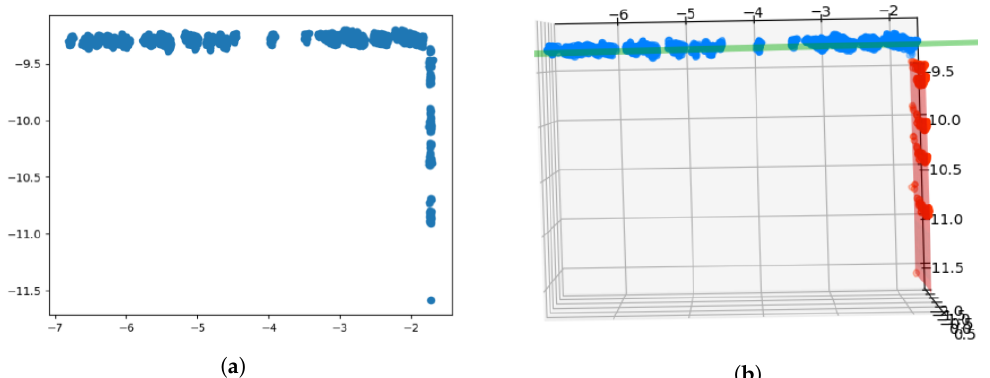
Figure 12. Results of extraction of intersected planes: ( a ) Input data to cluster planes; and ( b ) detection results of two intersecting planes, represented in red and green.